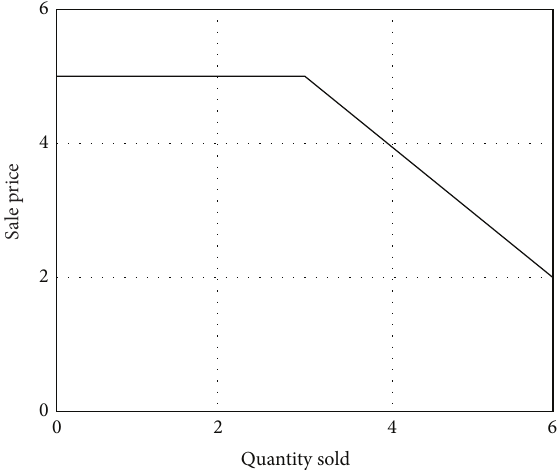
Figure 4: Graphical representation of relationship (1) in Matlab.